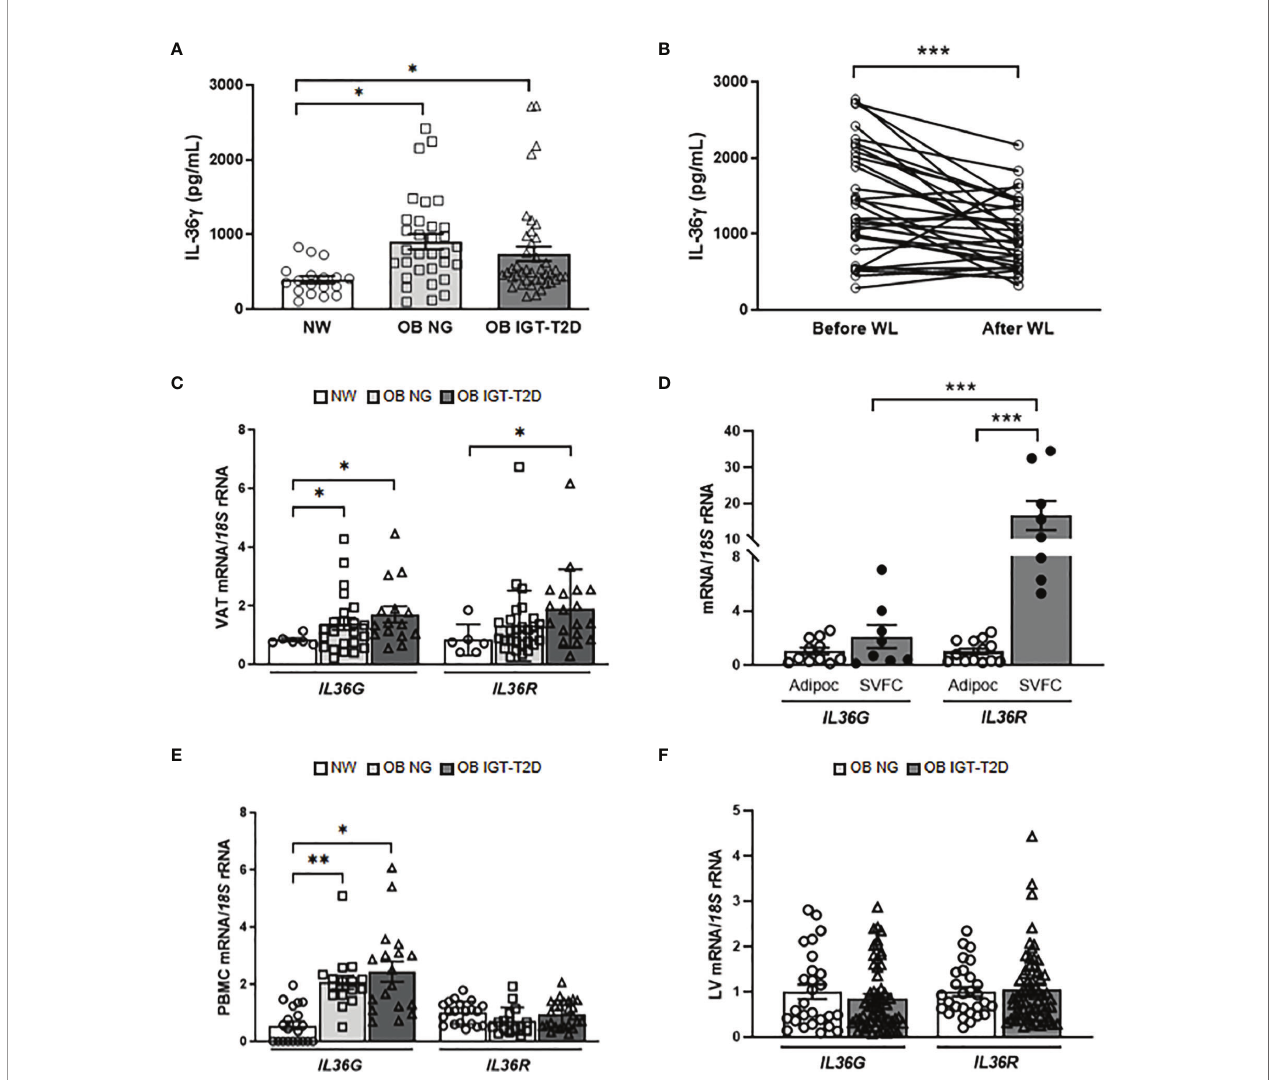
FIGURE 1 | Impact of obesity and obesity-associated T2D on IL-36 g levels. Effect of surgically-induced weight loss. (A) Fasting plasma concentrations of IL-36 g in normal-weight (NW) volunteers (n= 18) and patients with obesity (OB) without (NG, normoglycemic) (n= 32) or with impaired glucose toletance/type 2 diabetes (IGT- T2D) (n= 41) and (B) comparison of its concentrations determined in patients with obesity (n= 31) before and after weight loss achieved by Roux-en-Y gastric bypass. (C, D) Bar graphs show the mRNA levels of IL36G and IL36R in visceral adipose tissue (VAT) from NW volunteers (n=6) and patients with OB-NG (n= 23) and OB-T2D (n=15) as well as in adipocytes (n=11-13) and stromovascular fraction cells (SVFC) (n= 8) from patients with (n=6) or without T2D (n=8). (E) Gene expression levels of IL36G and IL36R in peripheral blood mononuclear cells (PBMC) were determined in NW volunteers (n=20) and patients with OB-NG (n=16) and OB-T2D (n=18-25) as well as (F) in the livers of volunteers with OB classi fi ed according to the presence (n=33) or not (n=28) of IGT-T2D. Bars represent the mean ± SEM. Differences between groups were analyzed by one-way ANOVA followed by Tukey ’ s tests as well as by unpaired and paired two-tailed Student ’ s t tests, where appropriate. * P < 0.05, ** P < 0.01 and *** P <